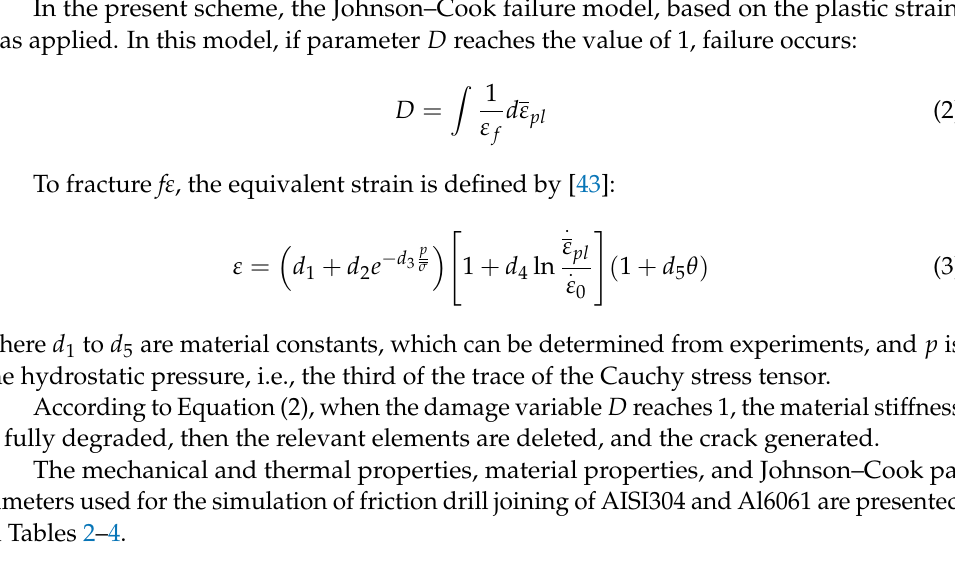
Table 2. Temperature-dependent Young’s modulus, specific heat, Poisson ratio, thermal conductivity, expansion coefficient, and mass density for AISI304 [17].